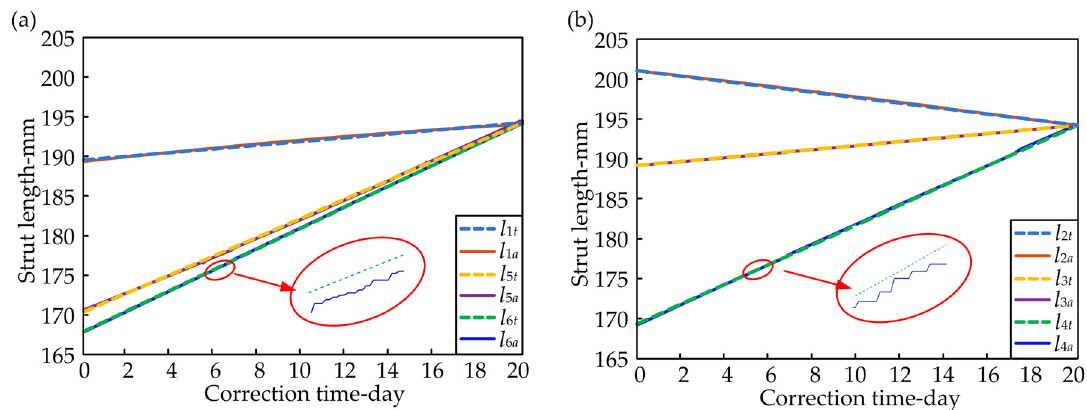
Figure 10. Theoretical ( l it ) and actual ( l ia ) values of rod length during correction with equal joint adjustment. ( a ) Theoretical ( l it ) and actual ( l ia ) values of length of rod 1, rod 5 and rod 6. ( b ) Theoretical ( l it ) and actual ( l ia ) values of length of rod 2, rod 3 and rod 4.